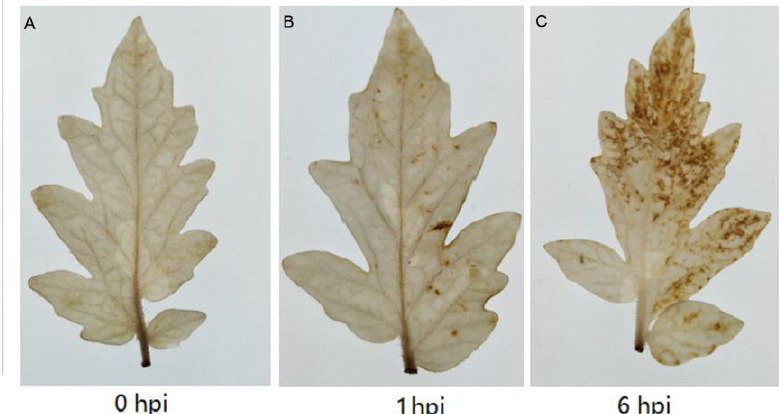
Figure 6. The detection of H 2 O 2 production in tomato leaves after inoculation with Botrytis cinerea by DAB: 0 h ( A ), 1 h ( B ), 6 h ( C ).